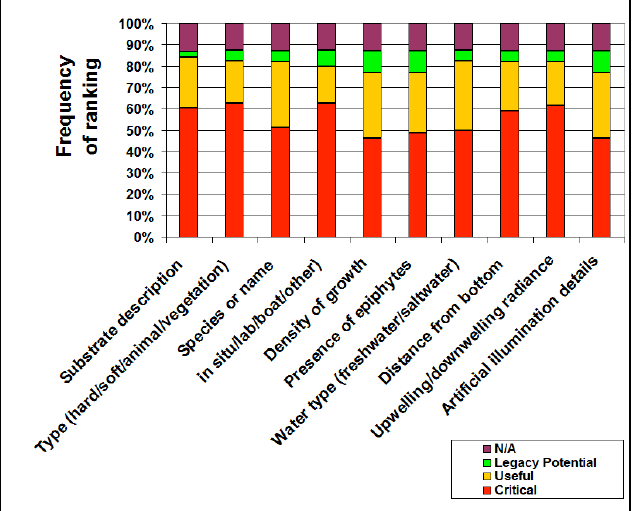
Figure 3.3 Frequency of criticality ranking for ‘substratum target ’ metadata ( n=40 )